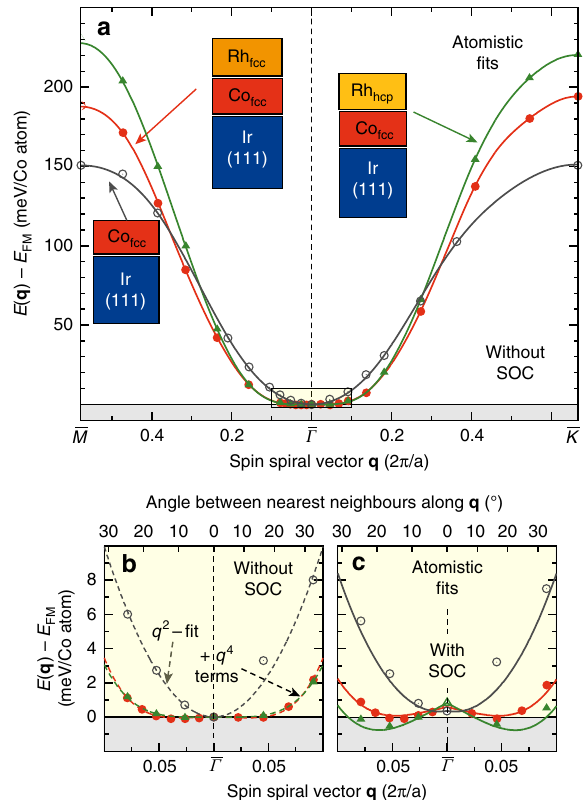
Fig. 4 Energy dispersion of spin spirals for ultrathin Co fi lms. a Energy dispersion of planar homogeneous spin spirals for Co/Ir(111), Rh fcc /Co/Ir (111) and Rh hcp /Co/Ir(111) along the high symmetry directions (cid:1) M (cid:2) (cid:1) Γ (cid:2) (cid:1) K of the two-dimensional Brillouin zone without spin – orbit coupling (SOC). Energies are given with respect to the FM state. The symbols (open gray circles for Co/Ir(111), red fi lled circles for Rh fcc /Co/Ir(111) and green triangles for Rh hcp /Co/Ir(111)) represent the DFT calculations while the solid lines are the fi ts to the Heisenberg exchange interaction beyond nearest neighbors (see Supplementary Note 2 for details). b Zoom around the FM state ( (cid:1) Γ -point) of a , where dashed lines represent a q 2 fi t in the case of Co/Ir(111) and a fi t including an additional q 4 term in the case of Rh/Co/Ir(111). c Zoom around the FM state ( (cid:1) Γ -point) of the energy dispersion for cycloidal spin spirals including the effect of spin – orbit coupling. The DMI leads to the local energy minima for clockwise rotating spin spirals along both high symmetry directions and the magnetocrystalline anisotropy energy is responsible for the constant energy shift of the spin spirals with respect to the FM